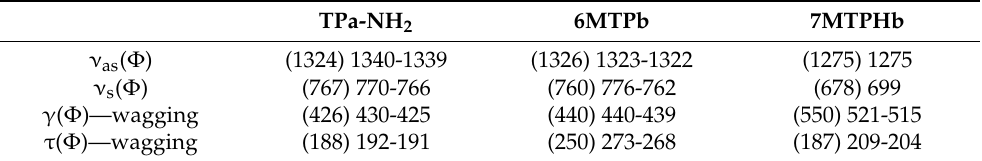
Figure 7. Comparison of the experimental and calculated infrared and Raman spectra of TPa-NH 2 . Table 3. Characteristic normal modes and their PED contribution to the skeleton in the studied triazolopyridine derivatives (the calculated values for the monomer are listed in